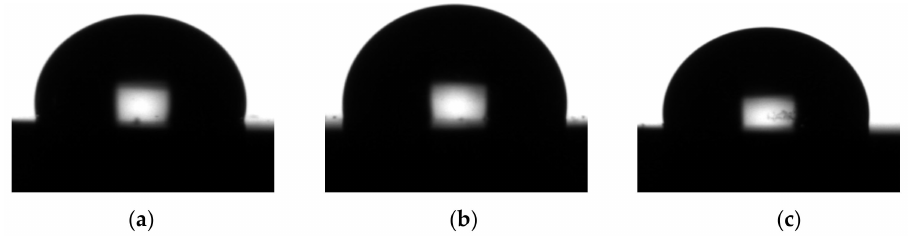
angle: 99.1 ◦ ); ( b ) DWW2 (contact angle: 97.2 ◦ ); ( c ) DWW3 (contact angle: 93.7 ◦